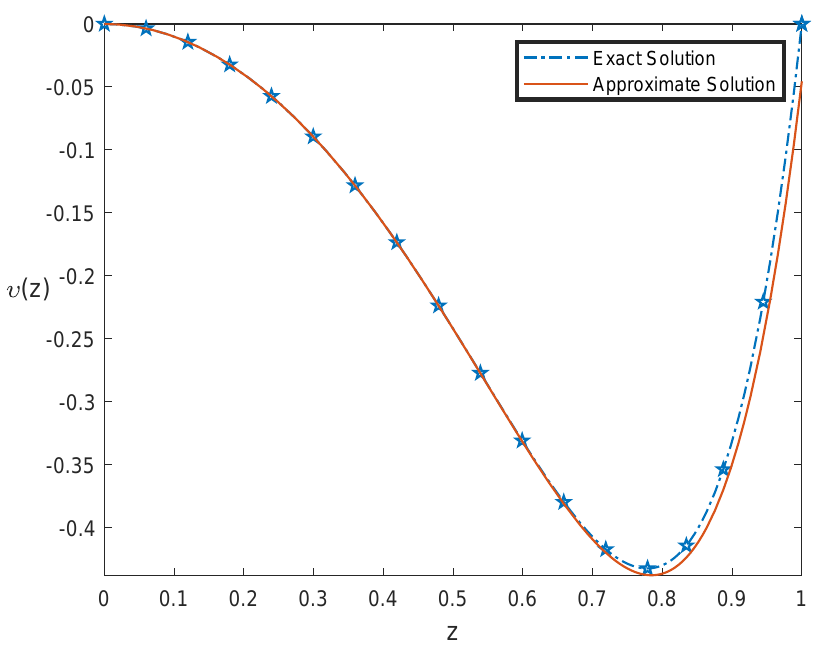
Figure 7. Graphs of exact solution and approximate solution of Example 6 with n = 7.